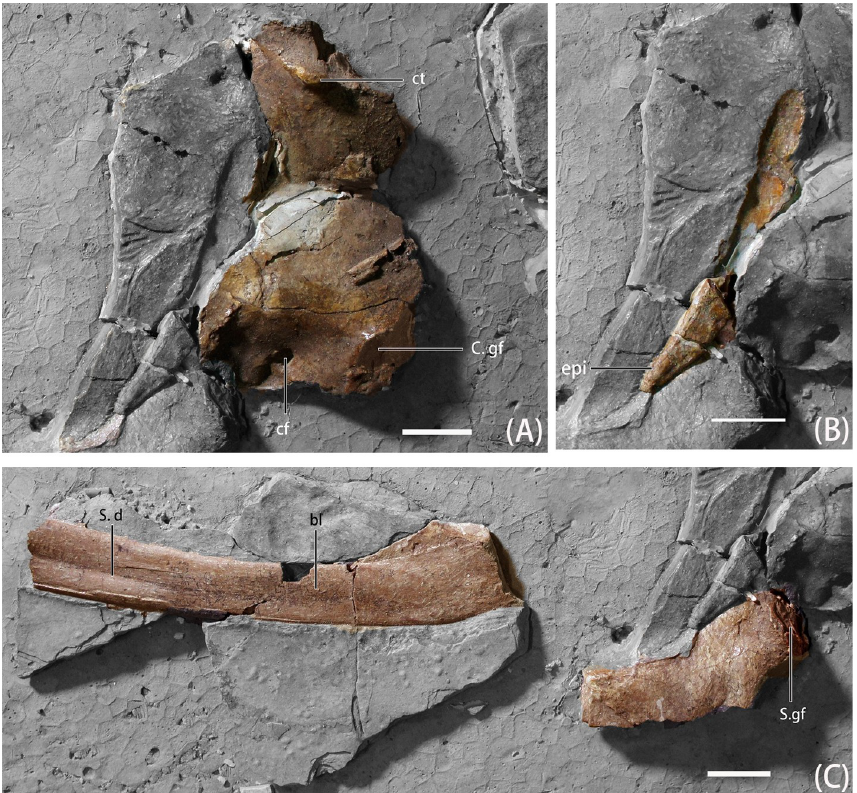
Fig 5. Photographs of pectoral girdle elements of B . inexpectus (IVPP V 11559) A. coracoids; B. furcula; C. scapula. Abbreviations: bl , blade; cf , coracoid foramen; C. gf , glenoid fossa of coracoid; ct , coracoid tubercle; epi , epicleidium; S. gf , Glenoid fossa of scapula; S. d , depression of scapula. Scale bars equal 2 cm.